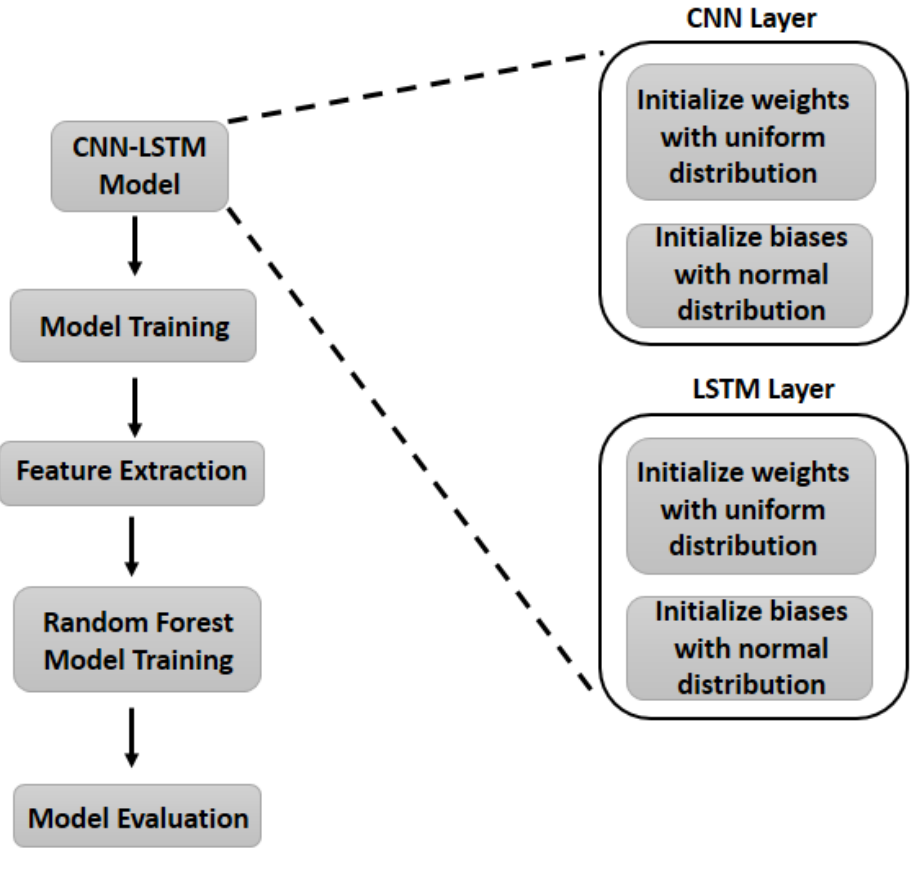
Figure 2. Architecture of the proposed